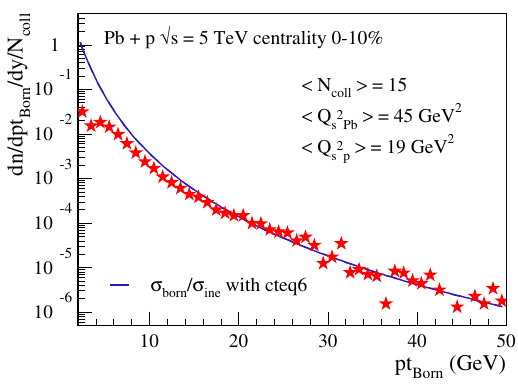
Figure 3. Born parton pt distribution normalized by the Glauber number of binary collisions from pPb collisions at 5.02 TeV for the 0-10% centrality bin. E pos 3.223 simulations are shown with stars and compared to the normalized inclusive cross-section (full